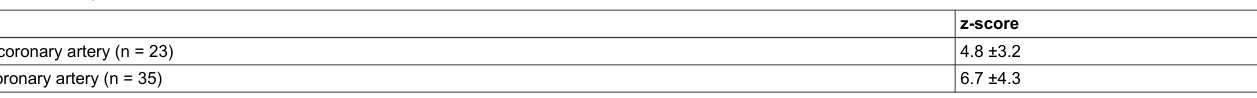
Table 3: Z-scores. Data are provided as mean and standard deviation.